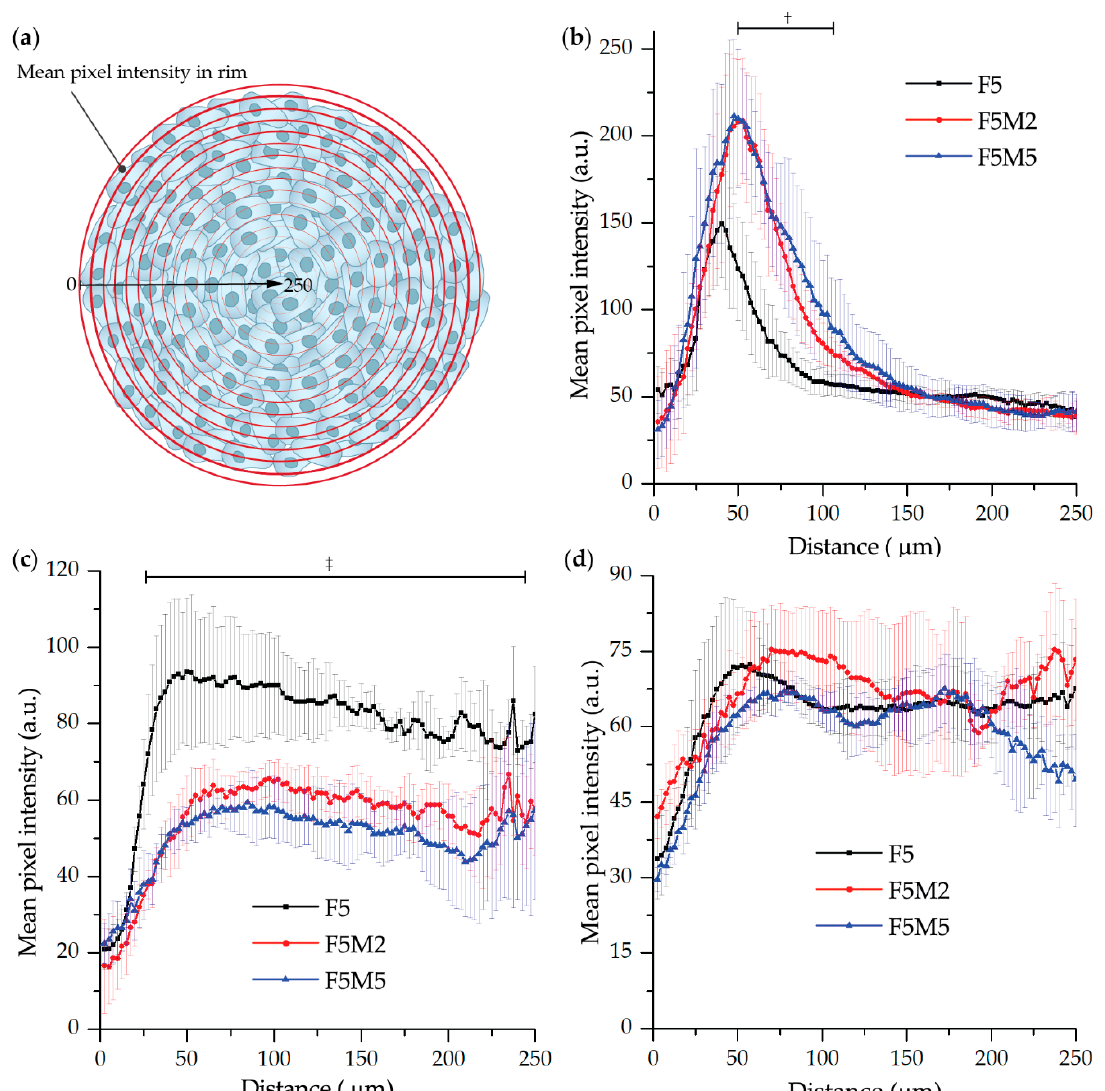
Figure 5. ( a ) The scheme of estimation of penetration profile in spheroid cryosections. ( b – d ) Penetration profiles of ( b) mTHPC, ( c ) Ce6 (4.5 µM) and ( d ) ICG (40 µM) in FaDu (black), FaDu:MeWo 5:2 (red) and FaDu:MeWo 5:5 (blue) spheroids at 5-day post-seeding after incubation for 24 h. † : statistically significant ( p < 0.05) difference in the range of 50–110 µm between F5 and F5M2/F5M5 treated with mTHPC, ‡ : statistically significant ( p < 0.05) difference in the range of 20–240 µm between F5 and F5M2/F5M5 treated with Ce6.